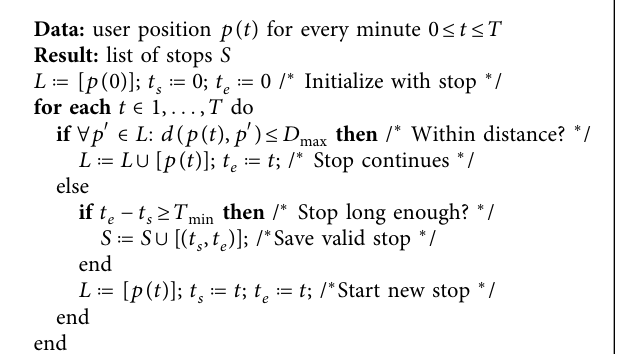
A LGORITHM 1: Stop detection as used by the STOP trip extraction algorithm. A stop ends once the next position is not in distance of all positions belonging to the current stop ( L